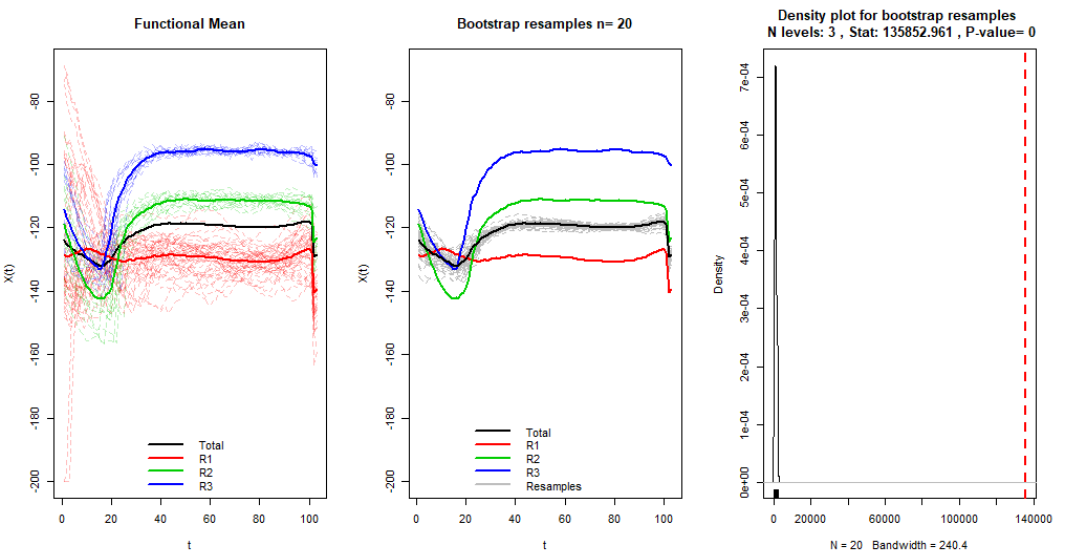
Figure 7. Functional ANOVA results of the analysis of the upper harmonic (USH) trajectories with the motor under high